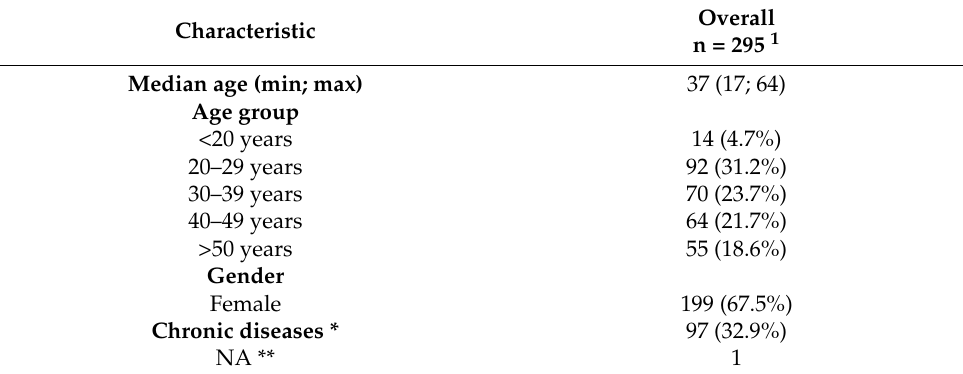
Table 1. Sociodemographic characteristics of the study population. Characteristic